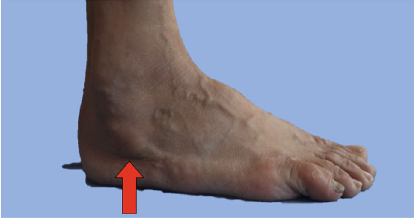
Figure 1: A bony protrusion had been palpitated on the lateral aspect of hindfoot (red arrow).